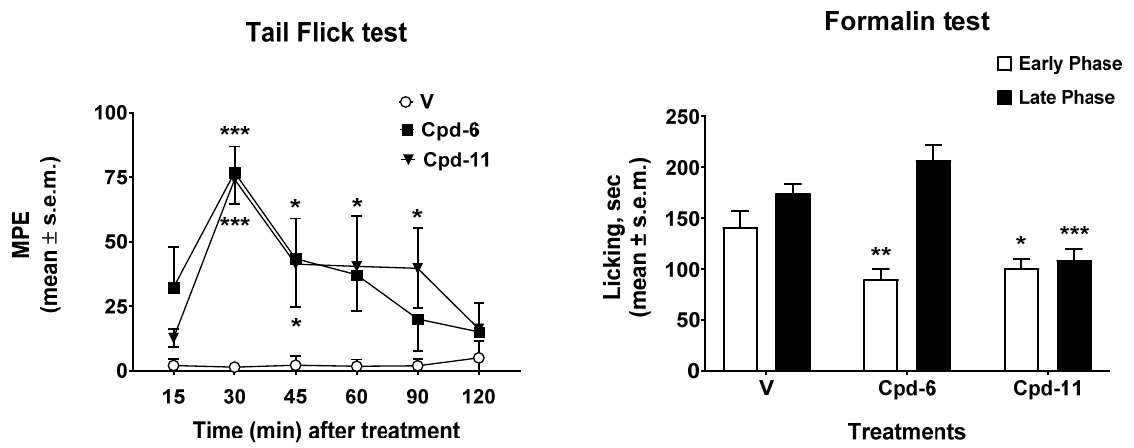
Figure 14. Effects induced by compounds 6 and 11 in the tail flick (left panel) and in the formalin (right test) tests. In the tail flick test, compounds were injected i.c.v. at a dose of 0.6 nmol/10 µ L. In the formalin test, compounds were injected s.c. in the dorsal surface of the hind paw, 15 min before formalin. V is for vehicle-treated animals. * is for p < 0.05; ** is for p < 0.01; *** is for p < 0.001. N = 7.